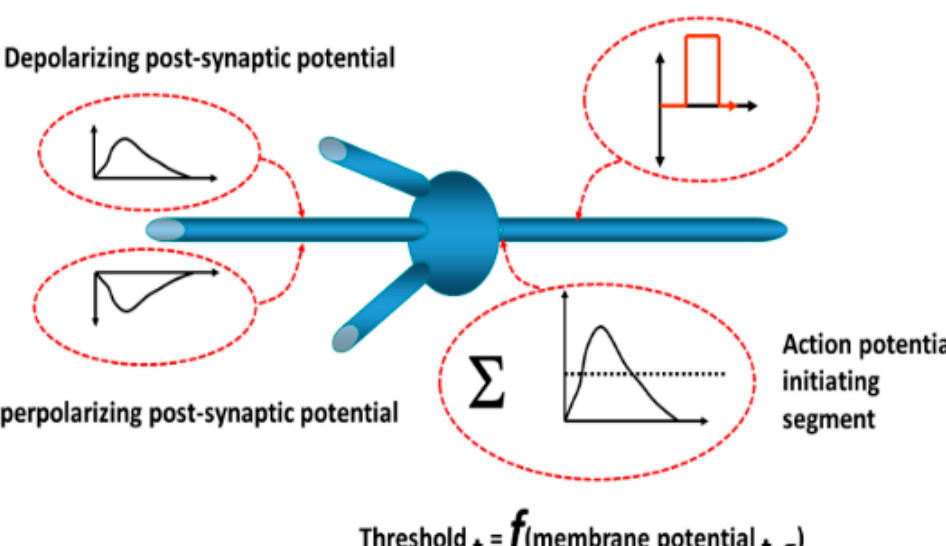
Figure 22. Model neurons consist of multiple dendritic inputs affecting the postsynaptic transmembrane electrical potentials. These inputs are summed at the action potential-initiating segment. If the summed potentials exceed a dynamic threshold, an action potential is generated. The postsynaptic potentials are modeled on as either a depolarizing or a hyperpolarizing decaying exponential function. The threshold, for example, at time t i , varies with the previous transmembrane electrical potential just prior at time t i-1 . This allows changes in Na + voltage-gated ionic conductance channel activation and inactivation. In this manner, post-hyperpolarization excitation and depolarization blockade are modeled [1].